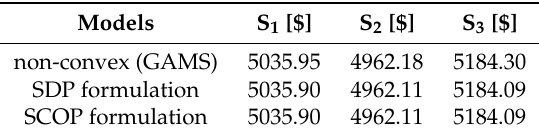
Table 5. Economic Dispatch Results.